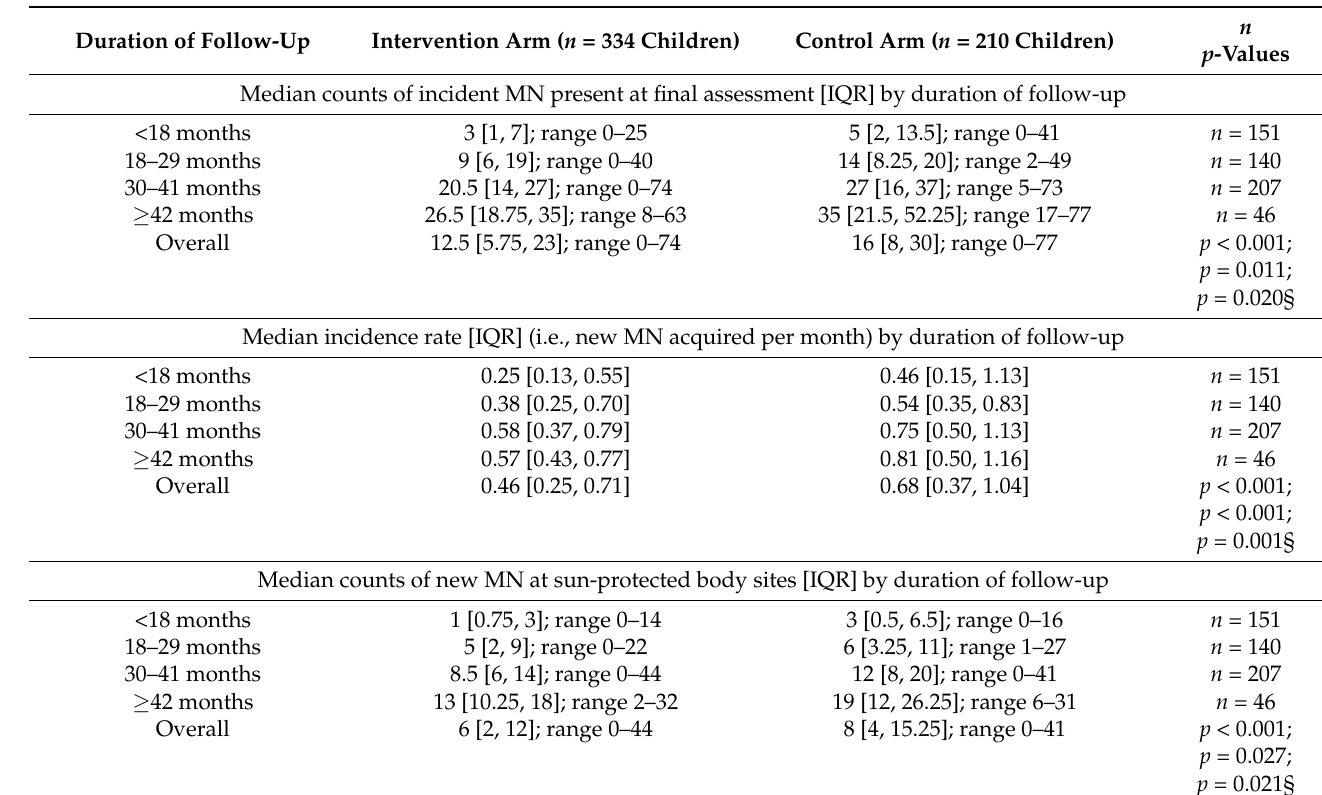
Table 3. Comparison between intervention and control children with regards to (i) total number of new melanocytic nevi (MN); (ii) number of new MN acquired per month; and (iii) number of new MN on body sites protected by study garments ¶ by duration of follow-up. Results based on 544 children followed for up to 4